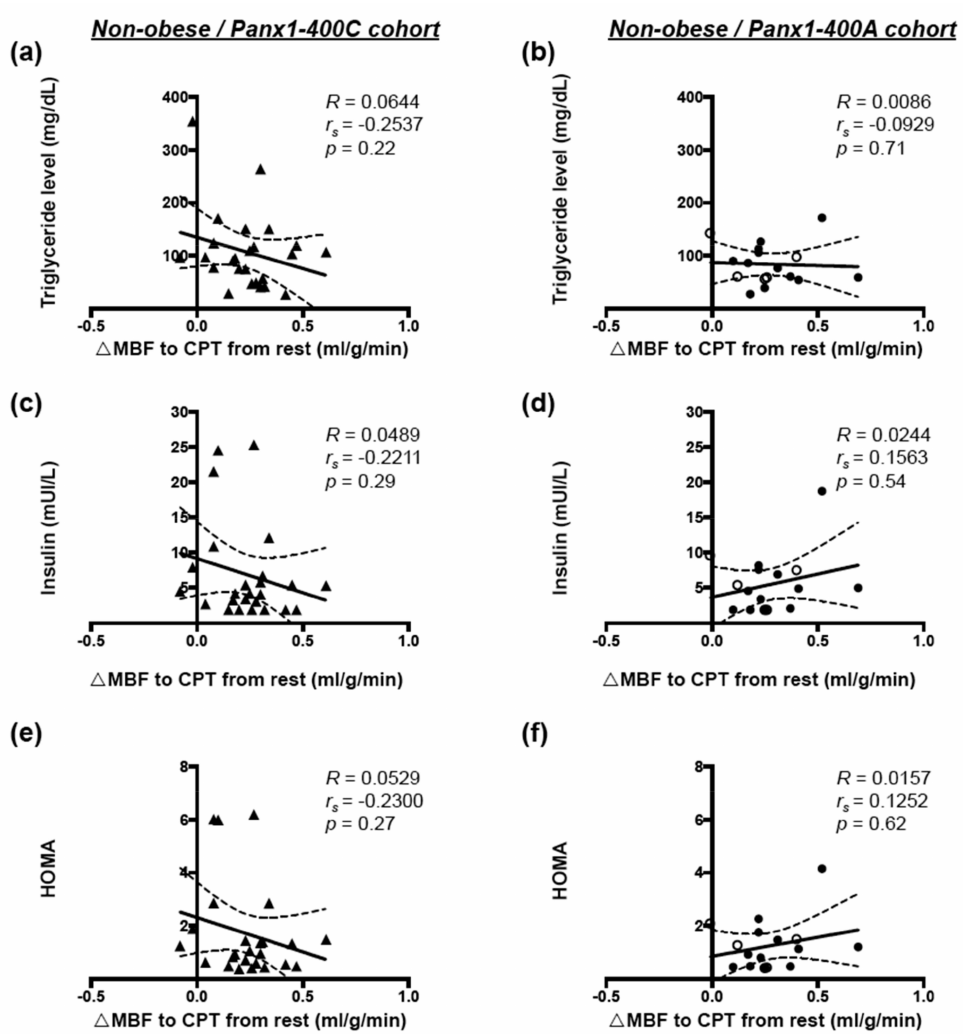
Figure 6. Correlation between endothelial function and cardiovascular risk factors in non-obese subjects. Spearman correlations in non-obese subjects between endothelial function and serum triglycerides ( a,b ), insulin ( c , d ), and HOMA ( e , f ) in the Panx1-400C cohort (( a , c , e ) n = 25) and the Panx1-400A cohort (( b , d , f ) n = 18). AA genotype: open circles; AC genotype: closed